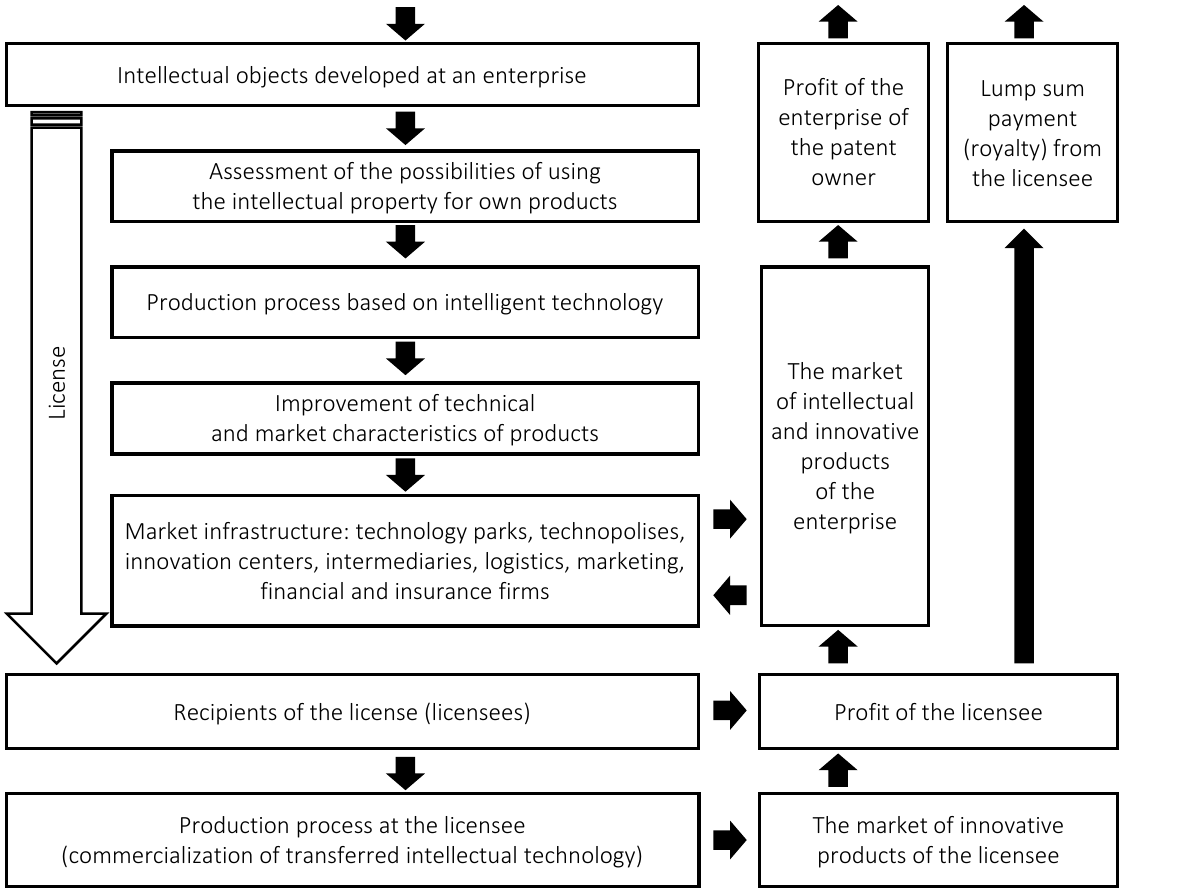
Figure 4. Vertical-horizontal commercialization of intellectual property objects